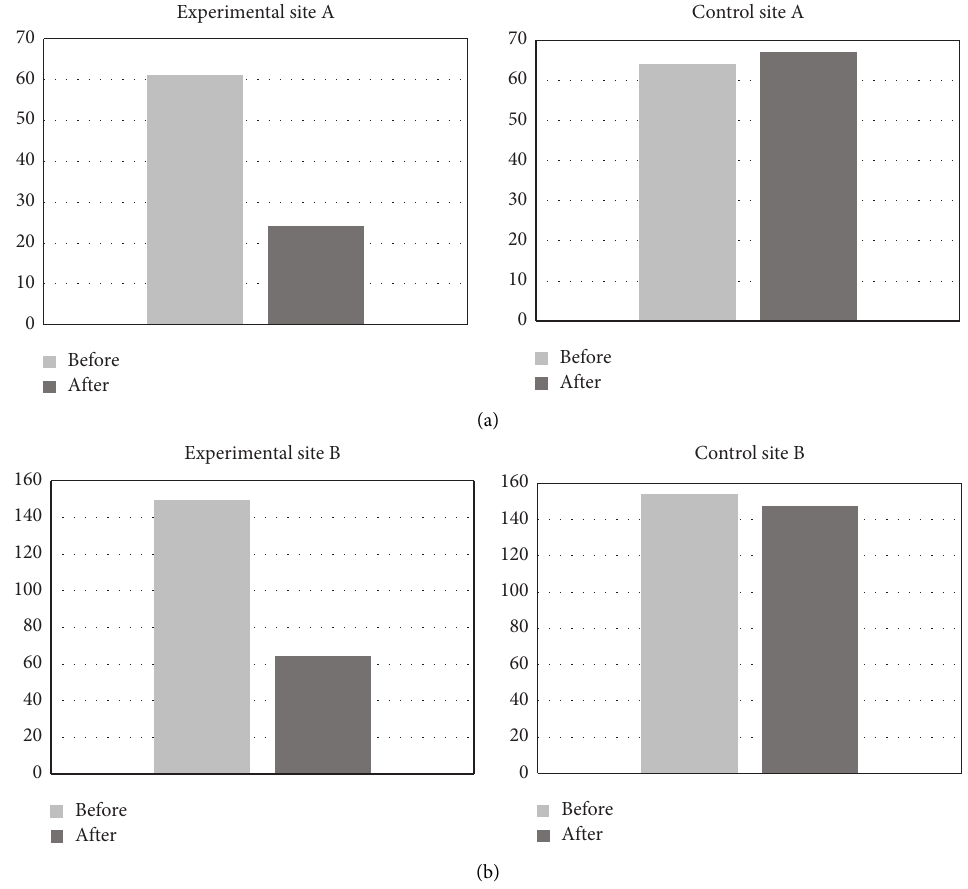
Figure 11: Number of trafc conficts in before-and-after periods: (a) experimental and control sites A (parking lot and underground parking entrance) and (b) experimental and control sites B (roadside parking